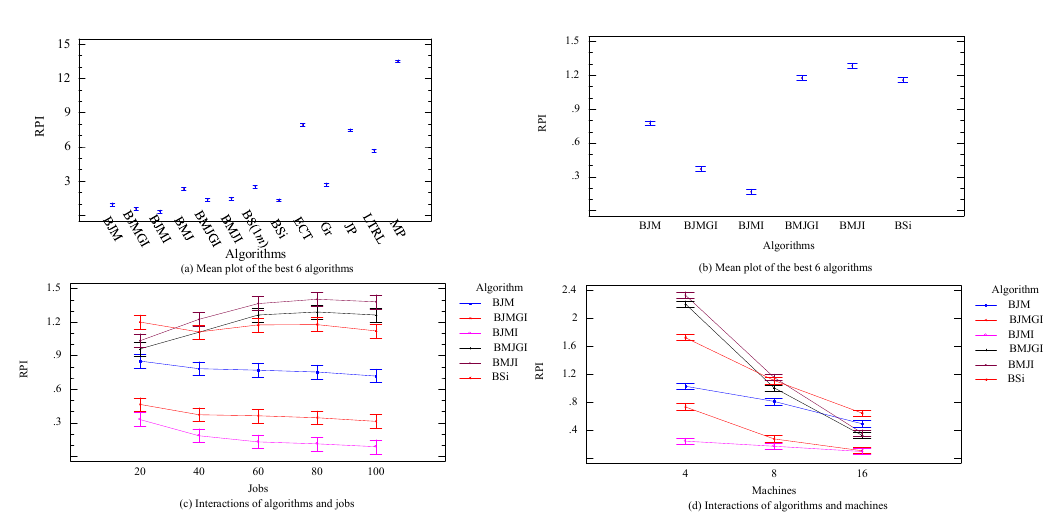
Fig. 8. Means plots, interactions and 95.0% Tukey HSD Intervals (large